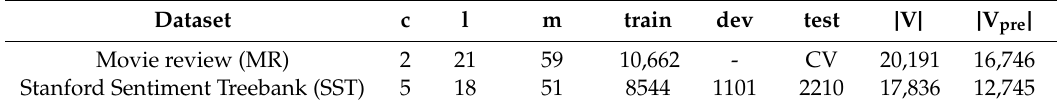
Table 1. The summary statistics of the two datasets. c: number of target classes, l: average sentence length, m: maximumsentencelength, train / dev / test: train / development / testsetsize, | V | :